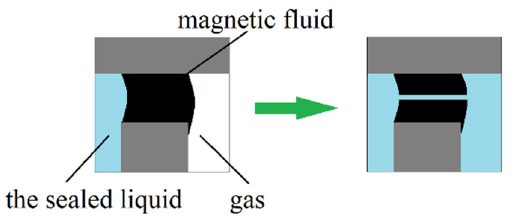
Figure 3. The instantaneous breakage process of the magnetic fluid film.